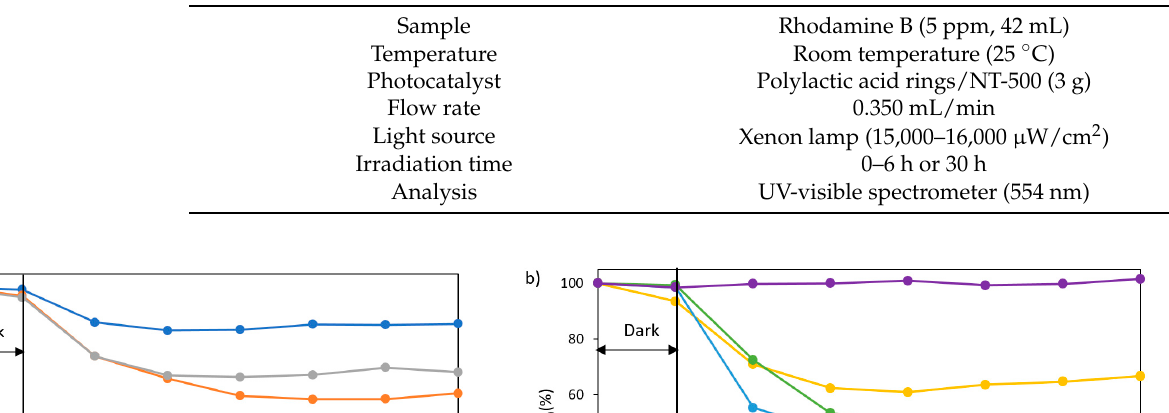
Table 2. Experimental conditions for degradation RhB by flow method under UV-Vis light irradiation.